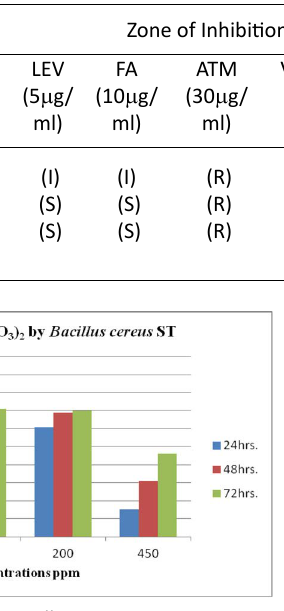
Fig. 15. Lead removal by Bacillus cereus ST